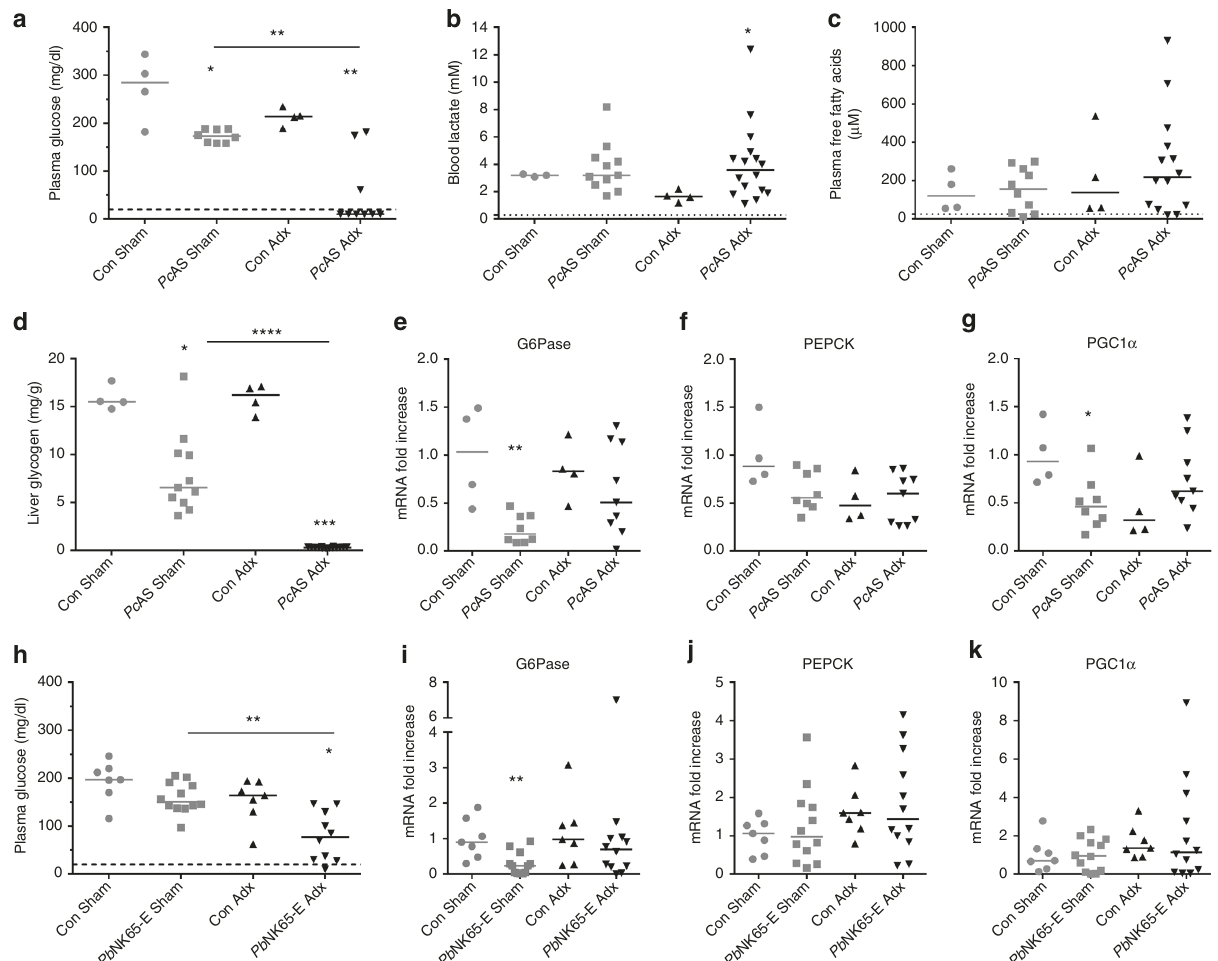
Fig. 5 Severe hypoglycemia and depleted glycogen stores without alterations in lactate, free fatty acids and hepatic gluconeogenic enzyme expression in infected Adx mice. Sham and Adx C57BL/6 or BALB/c mice were infected with Pc AS ( a – g ) or Pb NK65-E ( h – k ), respectively. Infected mice were euthanized and dissected at 8 to 10 days p.i. ( Pc AS) or 6 to 7 days p.i ( Pb NK65-E). a , h Glucose levels were determined in plasma (detection limit was 20 mg/dL, indicated by dotted line). Samples with a measurement below the detection limit, were given an arbitrary value of 10 mg/dL. b , c Blood lactate and plasma free fatty acid levels were measured. The dotted lines represent the limits of detection. d Hepatic glycogen content (in mg/g of tissue). ( e – g , i – k ) Livers were homogenized and speci fi c mRNA levels were measured by qRT-PCR. Each symbol represents data from an individual mouse, ( d ) n = 14 for Pc AS Adx. Horizontal lines in between data points represent group medians and analysis was by Mann-Whitney U -test. Horizontal lines with asterisks on top indicate the levels of statistical signi fi cance between the indicated groups. Asterisks above individual data sets indicate the levels of statistical signi fi cance compared to the uninfected control group. Data from at least two separate experiments. * p < 0.05, ** p < 0.01, *** p < 0.001, **** p <